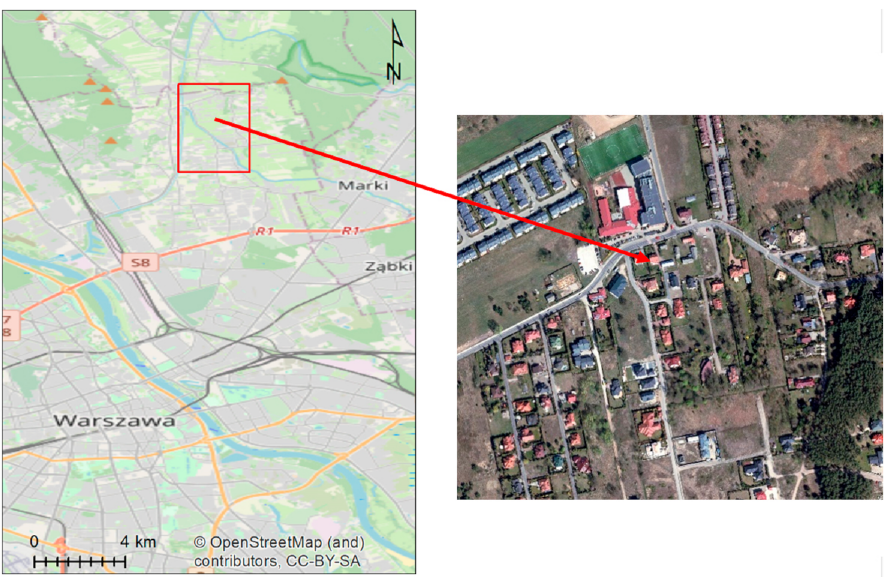
Figure 1. The study area: Warsaw and Kobiałka, the study region (marked by the red rectangle) and aerial orthoimage (selected